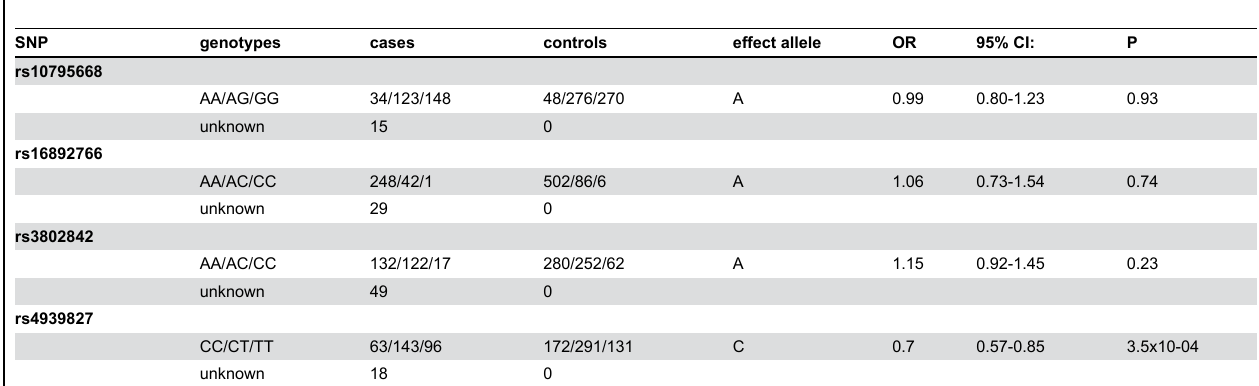
Table 2. The association between variants rs10795668, rs16892766, rs3802842 and rs4939827 and colorectal cancer in Croatian